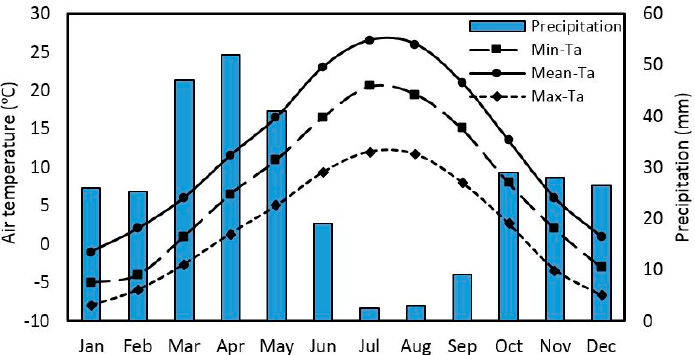
Figure 2. Monthly minimum/mean/maximum air temperature and precipitation in Tabriz, Iran [52] .